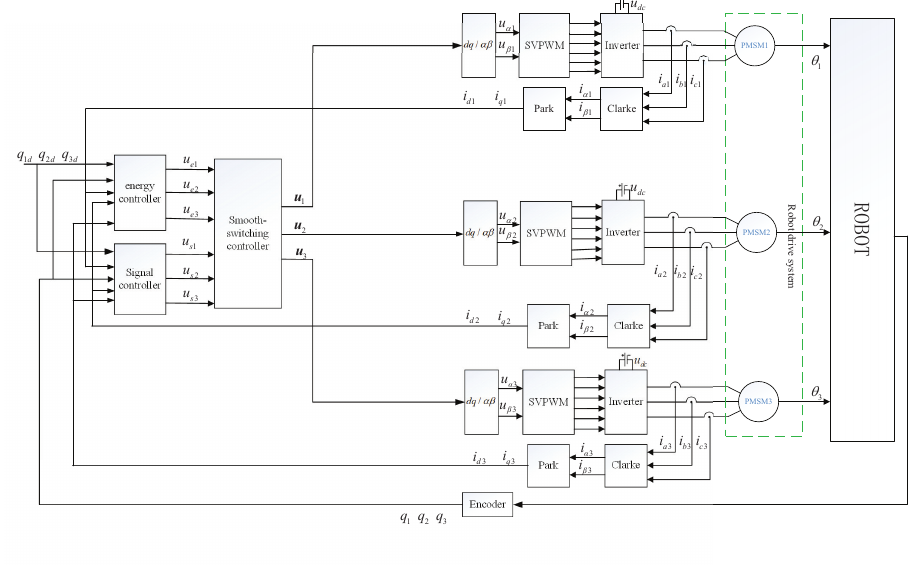
Figure 2. Block diagram of robot drive